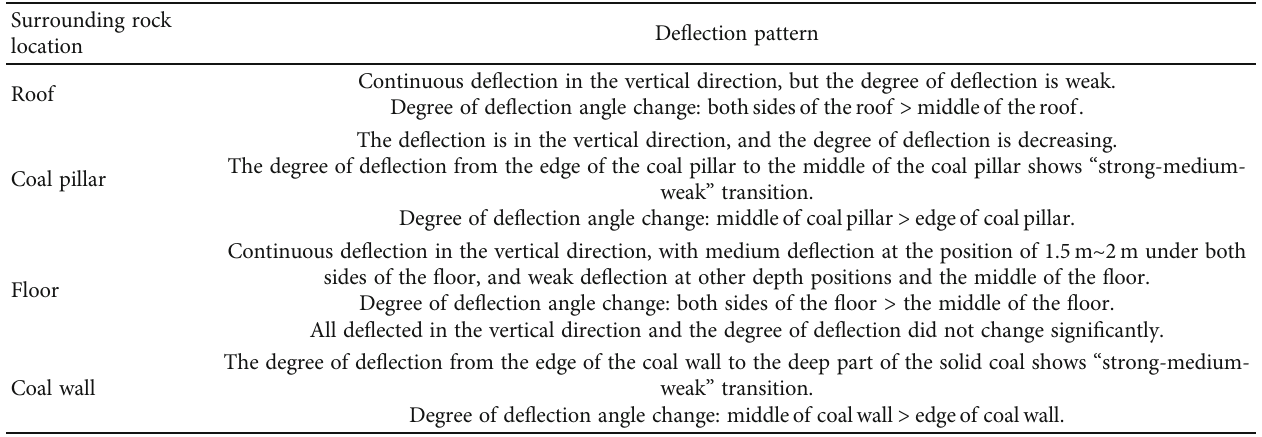
Distance from the right edge of the floor